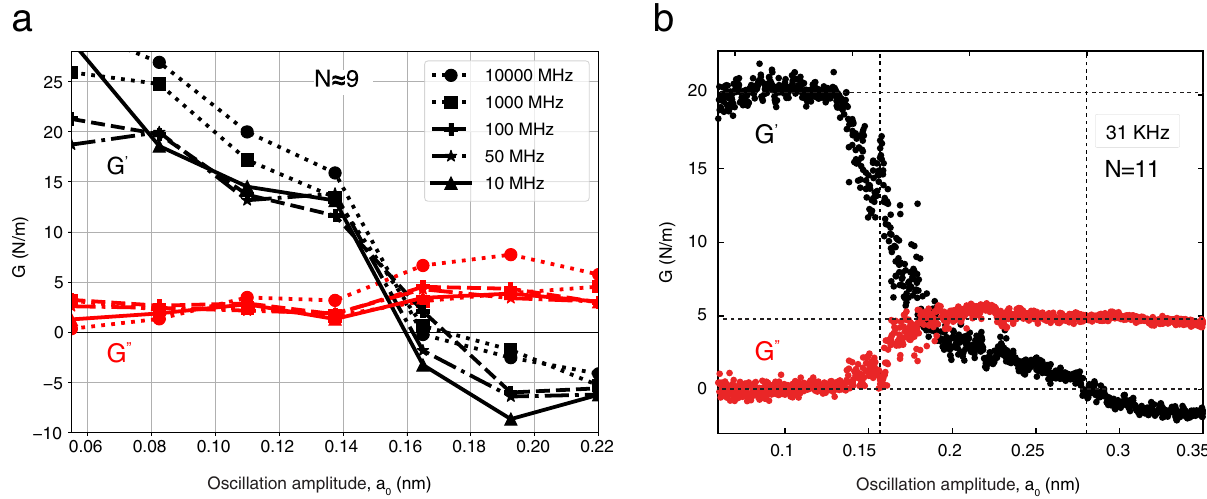
Fig. 3 Complex dynamical response function. a Effective stiffness G 0 and dissipation G ″ at three decades of frequency 10 MHz – 10 GHz for a N ≈ 9 atom cross section nanojunction. Similar results are obtained for different sizes and frequencies (see Supplementary Fig. 2 for the largest size of N ≈ 26). b Experimental data for N = 11 at 31 KHz reproduced from ref. 14 . Note the good overall agreement, parameter-free. For lower frequency data at 1 MHz close to simulation limit, see Supplementary Fig.